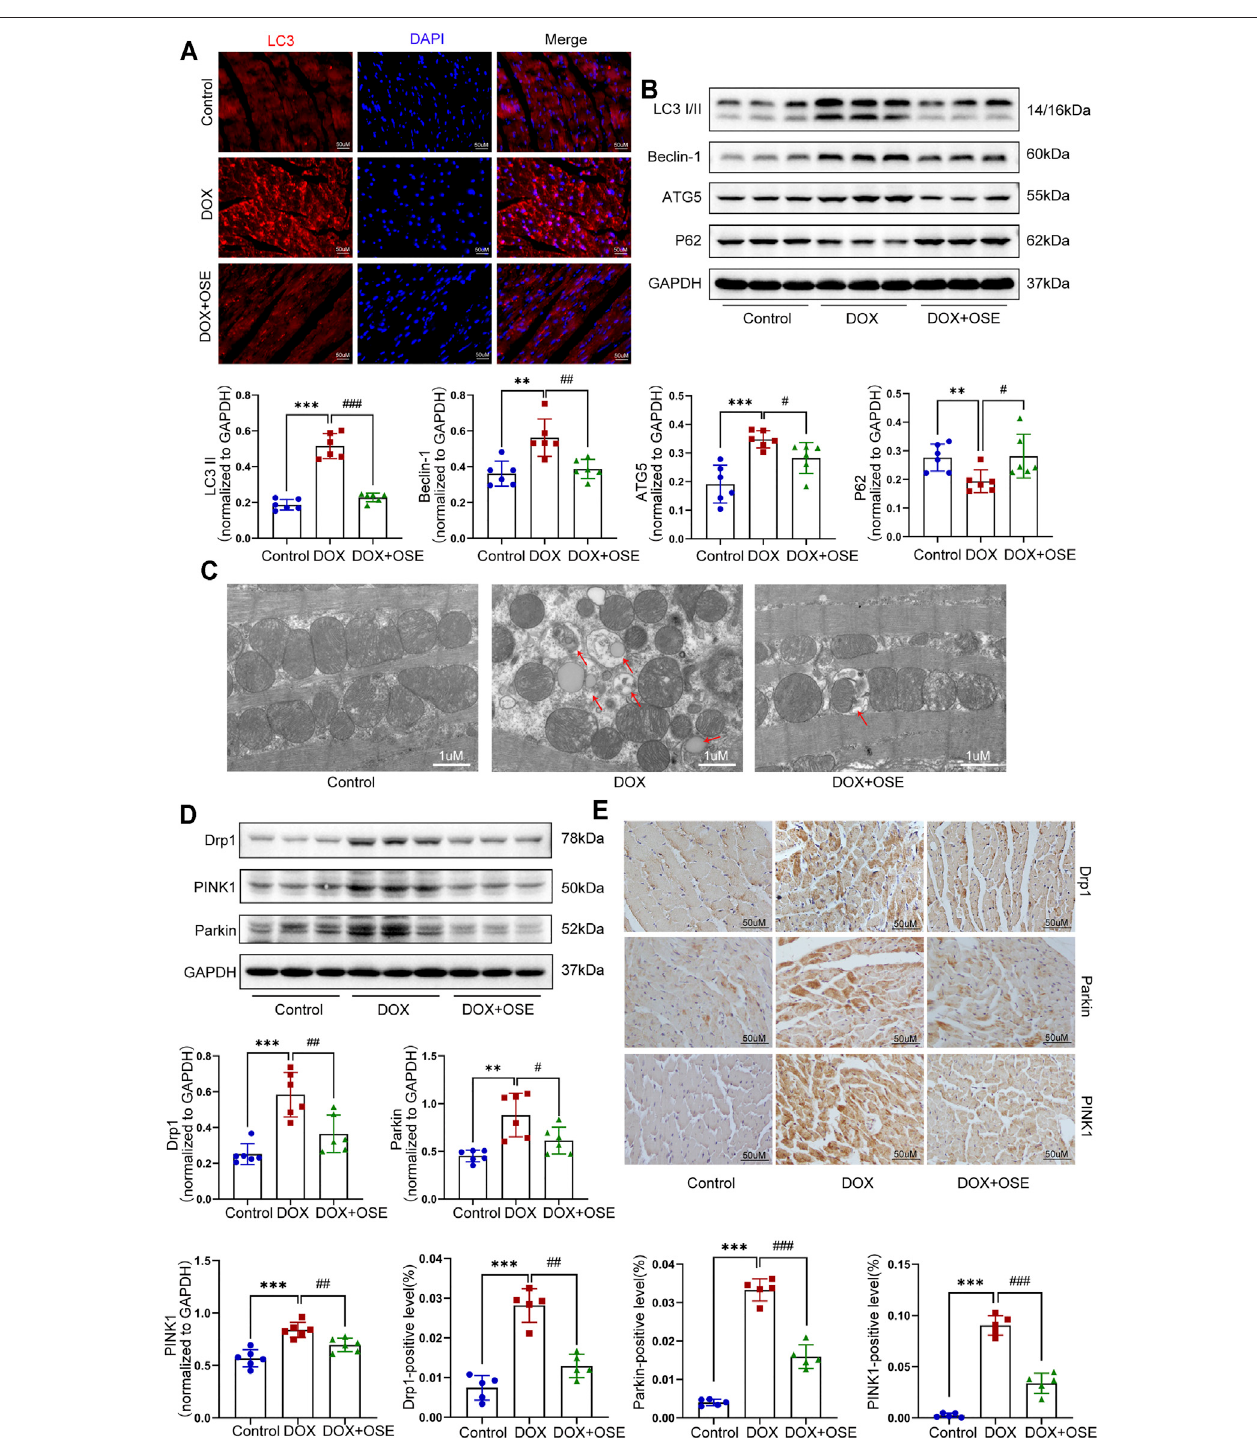
FIGURE3| NEU1inhibitormodulatedautophagy,mitochondrial fi ssion,andmitophagyinDOX-treatedrathearts. (A) RepresentativeimagesofLC3IIexpressionin hearttissuesofthethreegroups(scalebar (cid:1) 50 μ m). (B) Theexpression levelsofLC3I/II, ATG5,Beclin 1,and P62inhearttissuesofthedifferentgroupsbywesternblot ( n (cid:1) 6pergroup). (C) Representativeelectronmicroscopyimagesofhearttissuesinthethreegroups;theredarrowsdirectautophagicvacuolescontainingcargos(scale bar (cid:1) 1 μ m). (D) The expression levels ofdynamin-related protein 1(Drp1), PINK1, and Parkininhearttissues ofthe threegroups bywesternblot( n (cid:1) 6 per group). (E) Representativeimmunohistochemicalimages ofDrp1, PINK1,andParkinexpressions inhearttissuesofthethree groups( n (cid:1) 5pergroup, scalebar (cid:1) 50 μ m).(** p < 0.01 vs. control group, *** p < 0.001 vs. control group. # p < 0.05 vs. DOX group, ## p < 0.01 vs. DOX group, ### p < 0.001 vs. DOX group).